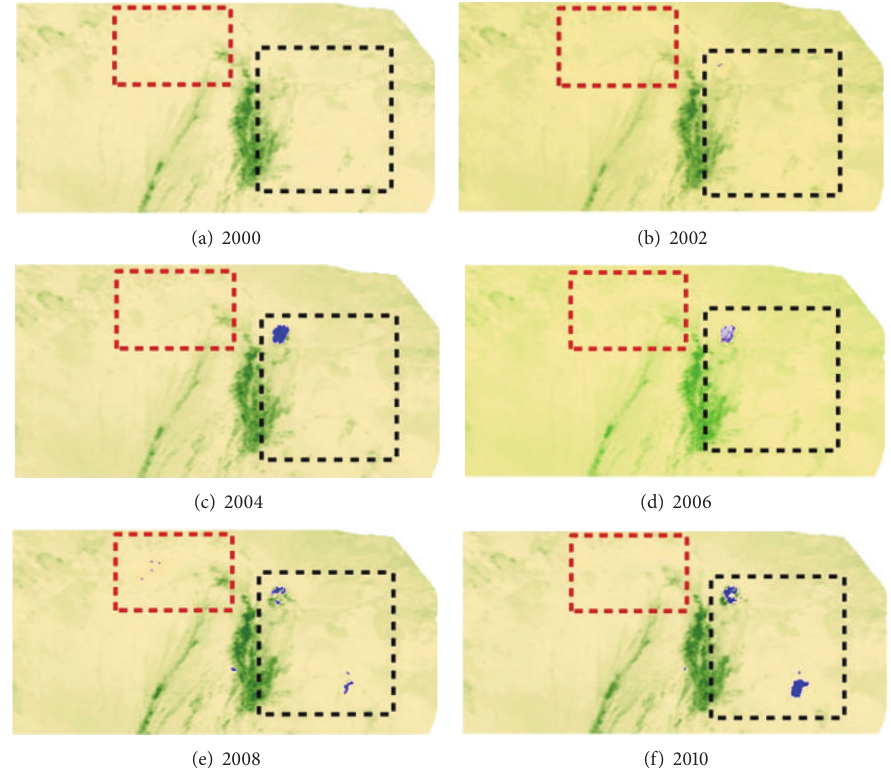
Figure 5: Variations in water bodies in both East and West Juyan Lakes. ∗ The black and red dotted lines encompass the regions of the East and West Juyan Lakes,